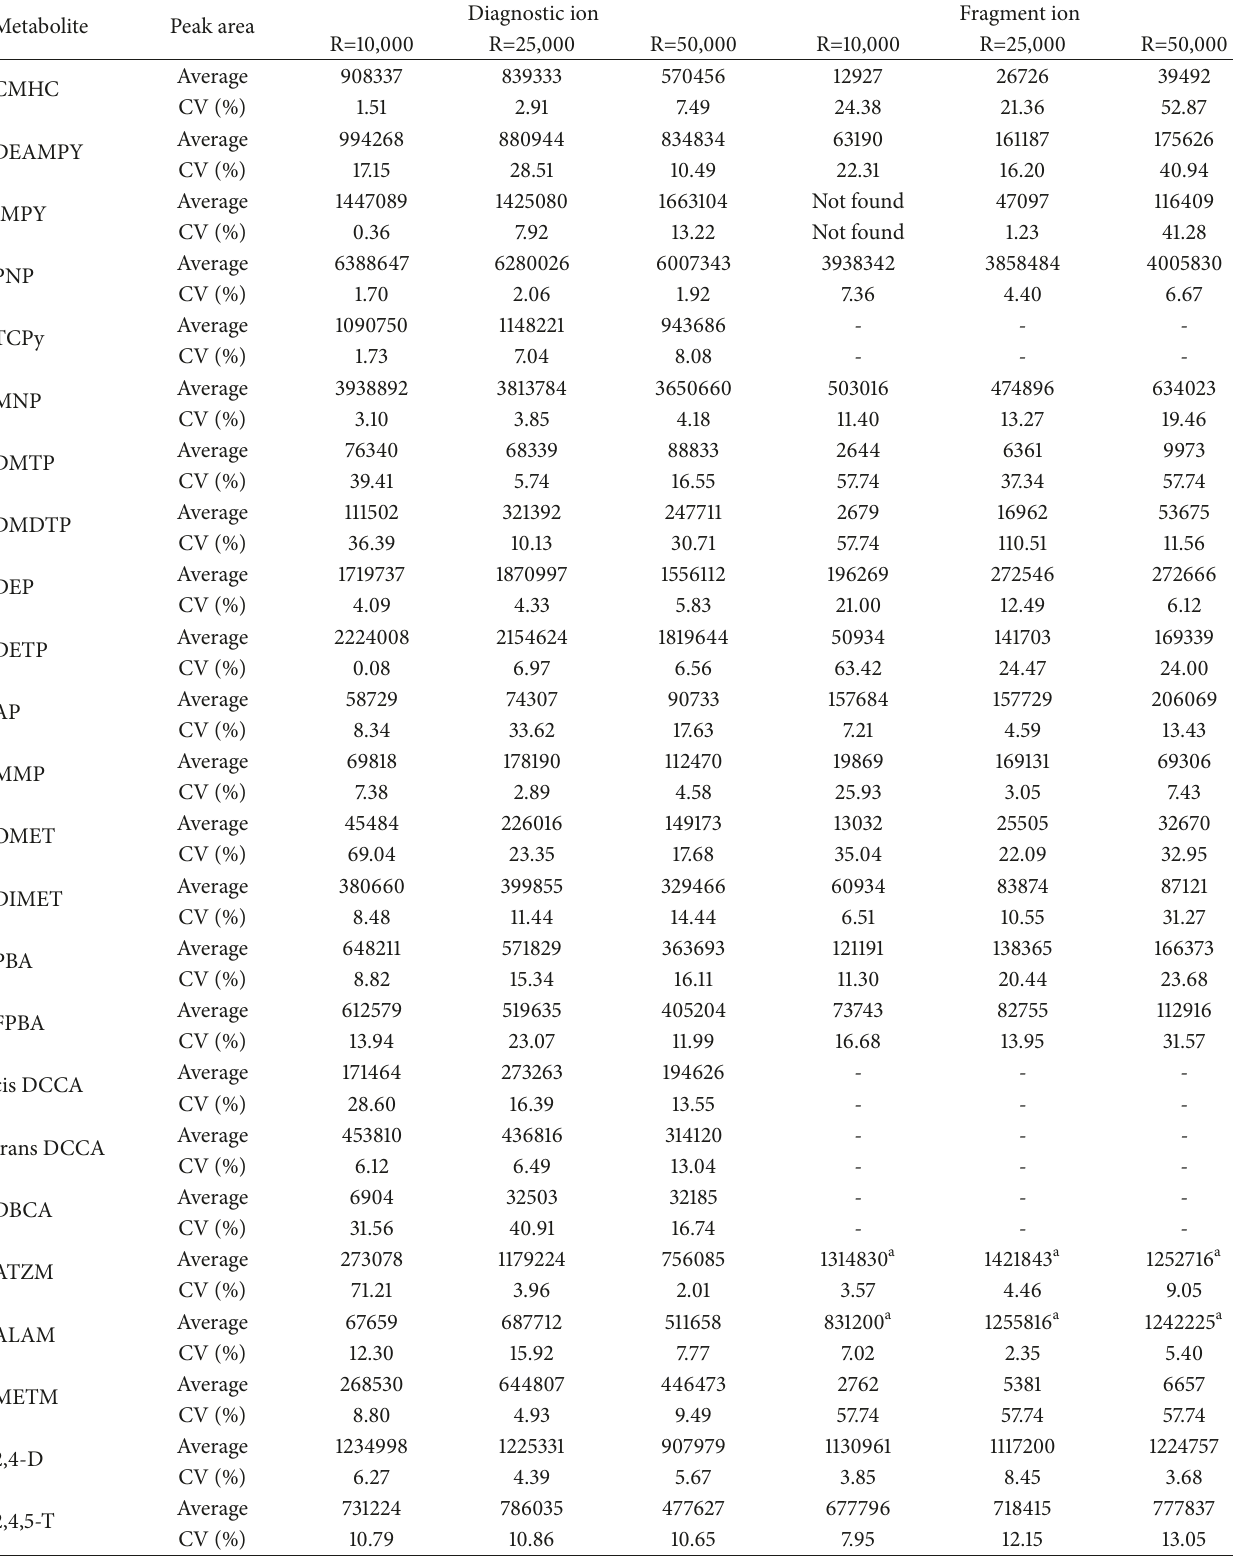
Table 2: Average peak area and coefficient of variation (CV, %) obtained at 3 different Resolving Powers (R) for pesticide metabolites diagnostic and fragment ions (n =